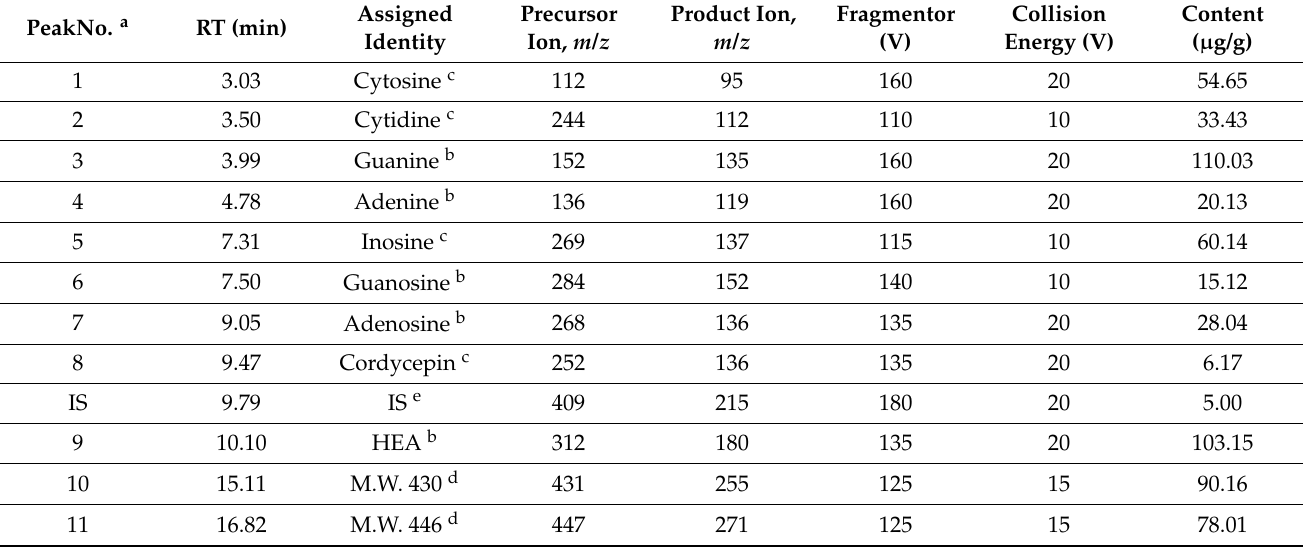
Figure 1. Highperformance liquid chromatography (HPLC) chromatogram of Cordyceps cicadae mycelia extract detected at full-range wavelength (210–400 nm) absorption by photodiode array detector. Peak numbers are described in Table 1. Table 1. HPLC-DAD-ESI-MRM analysis on the nucleobases their derivatives compositions of aqueous extract of Cordyceps cicadae mycelia.